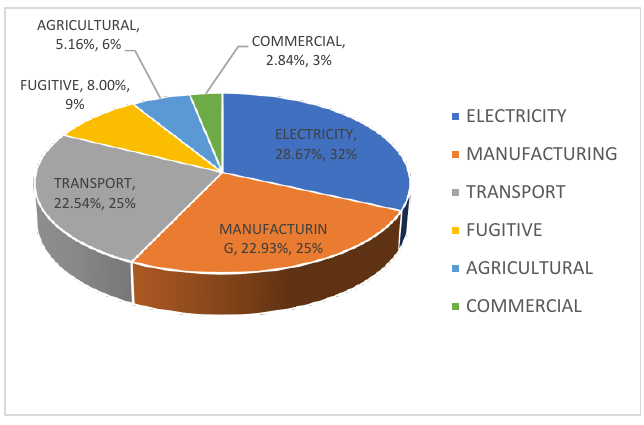
Figure 3. GHG emissions of various sectors [14].